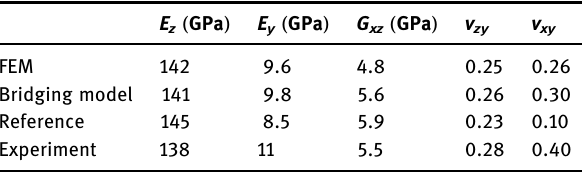
Table 5: Comparison of T300/BSL914C composite equivalent